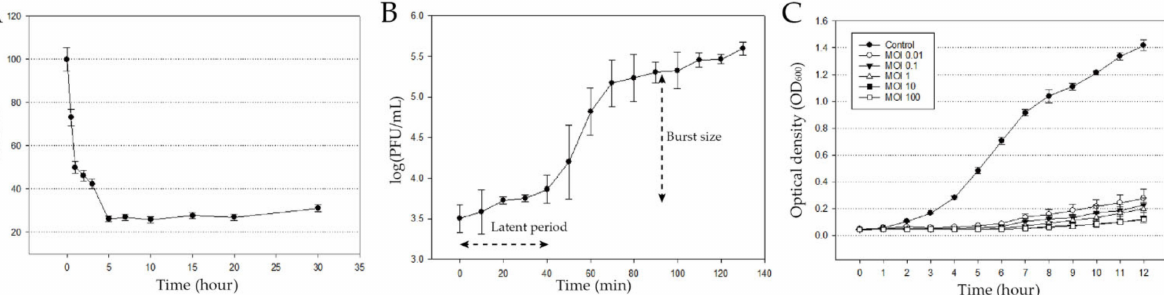
Figure 2. Biological features of pPa_SNUABM_DT01. ( A ) Adsorption assay of pPa_SNUABM_DT01 to host bacterial strain. ( B ) One-step growth curve of pPa_SNUABM_DT01 to host bacterial strain. ( C ) In vitro planktonic cell lysis assay of pPa_SNUABM_DT01 at different MOIs against host